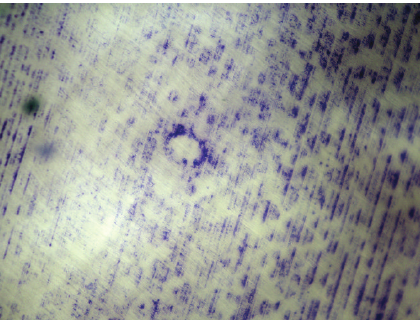
Figure 2: A resorption lacuna is made visible on the dentine chip through toluidine blue staining. The picture was taken under light microscopy at 10x magnification, 7 days after differentiation. The sample in this picture consisted of osteoclasts that were not stimulated with pantoprazole.